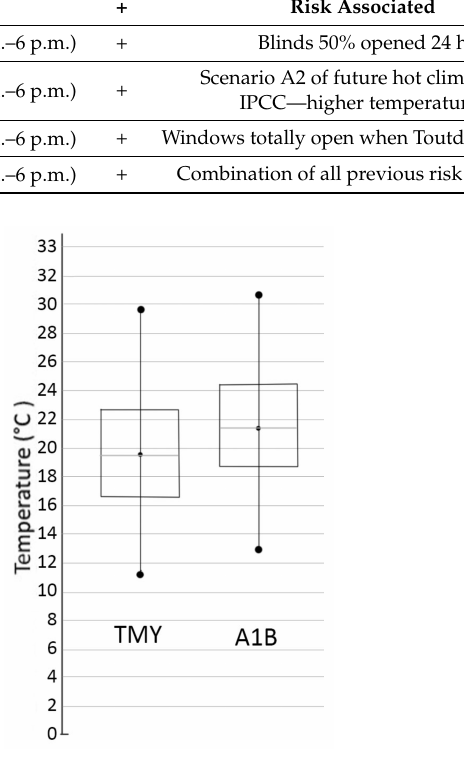
Figure 2. Comparison of the average dry-bulb temperature for the TMY climatic files and the future scenario A1 form